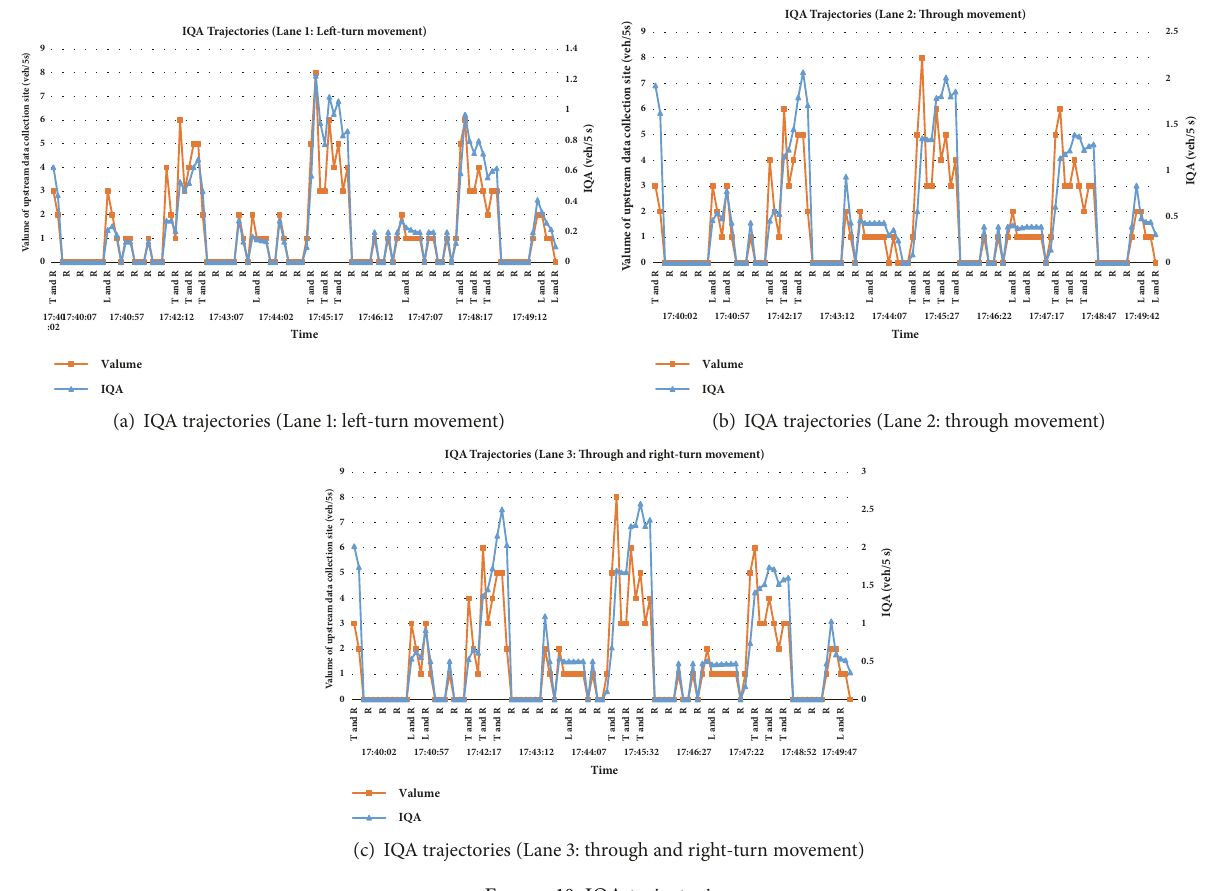
Figure 10: IQA trajectories. Table 5: Average IQA (veh/5 seconds) under the influence of different upstream turning flows (period: 17:40–17:50). Lane Upstream turning flow